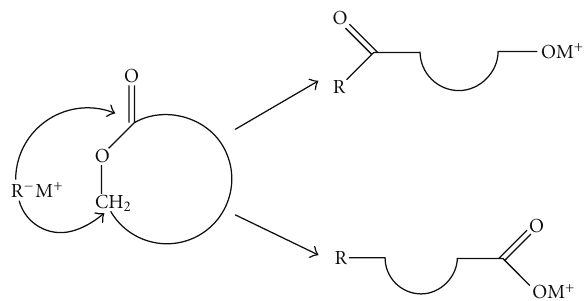
Scheme 7: Initiation of ring opening polymerization of Lactones by Anionic